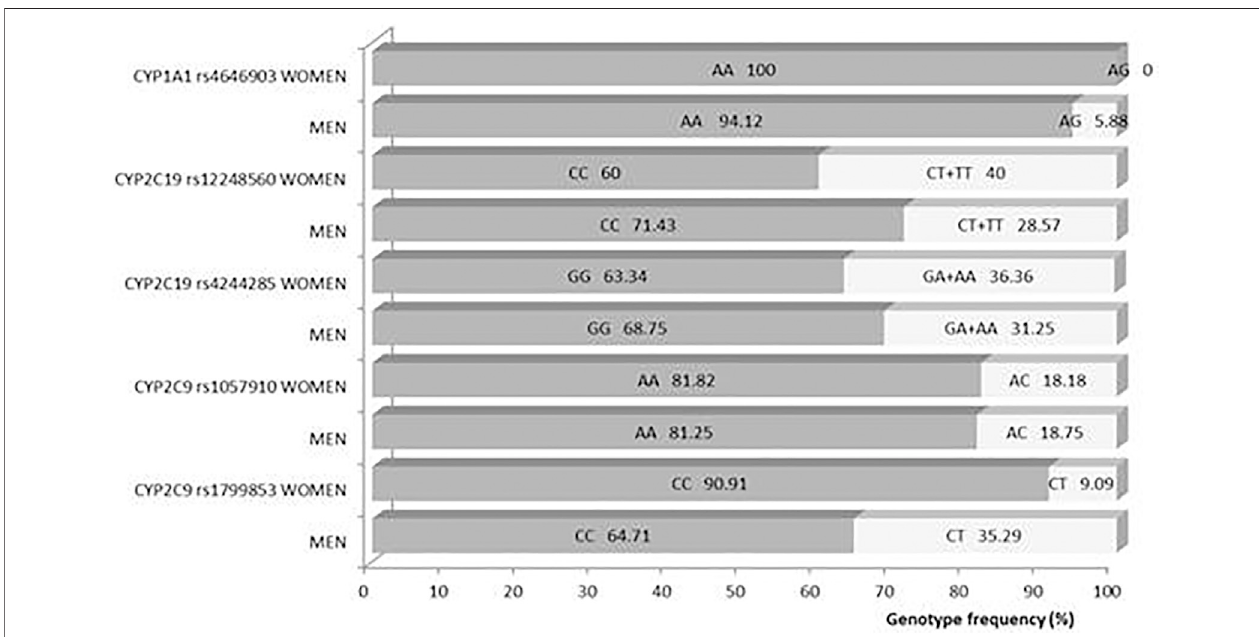
FIGURE 7 | Difference of genotype frequencies between